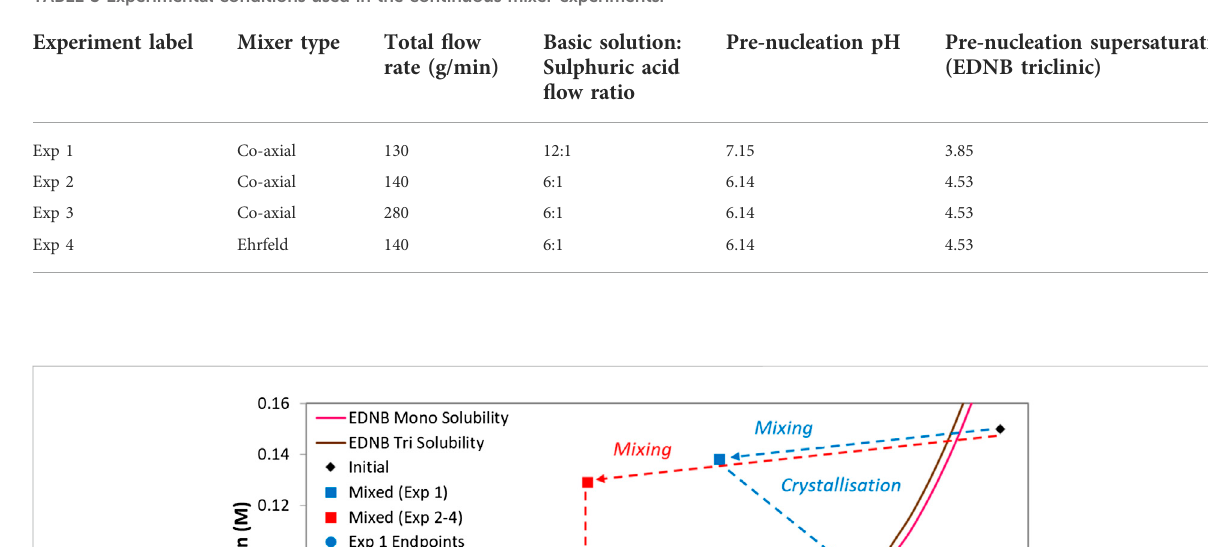
TABLE 3 Experimental conditions used in the continuous mixer experiments.